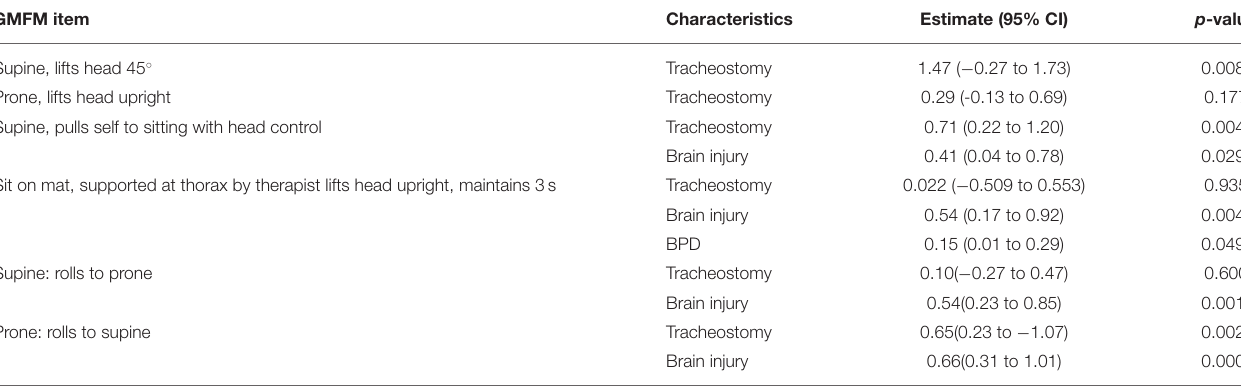
TABLE 3 | Multivariate general estimating equation according to each